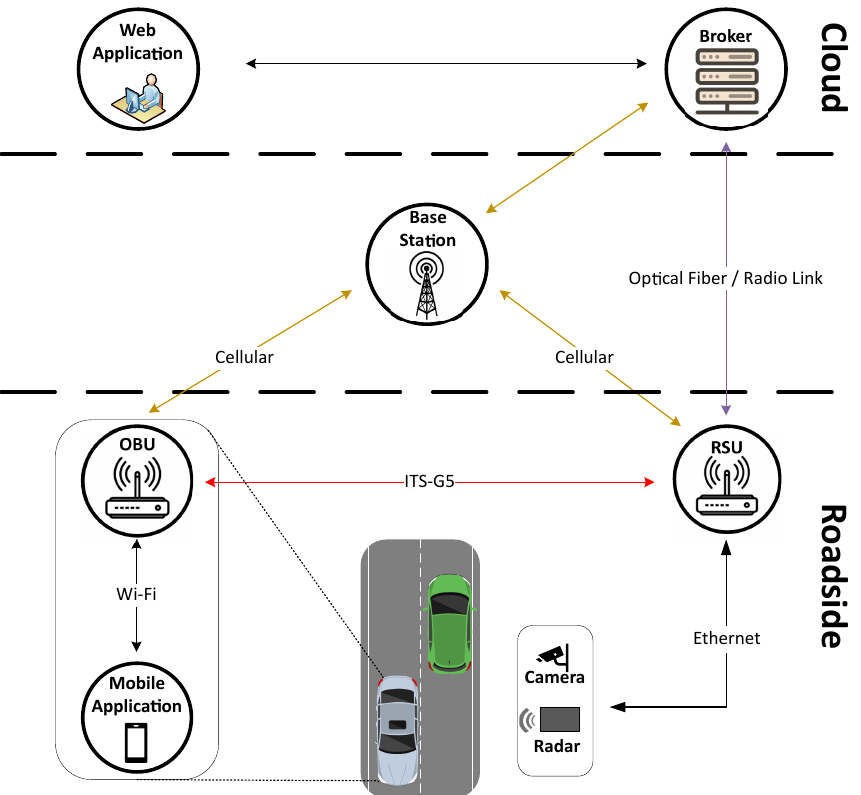
Figure 2. Overall system